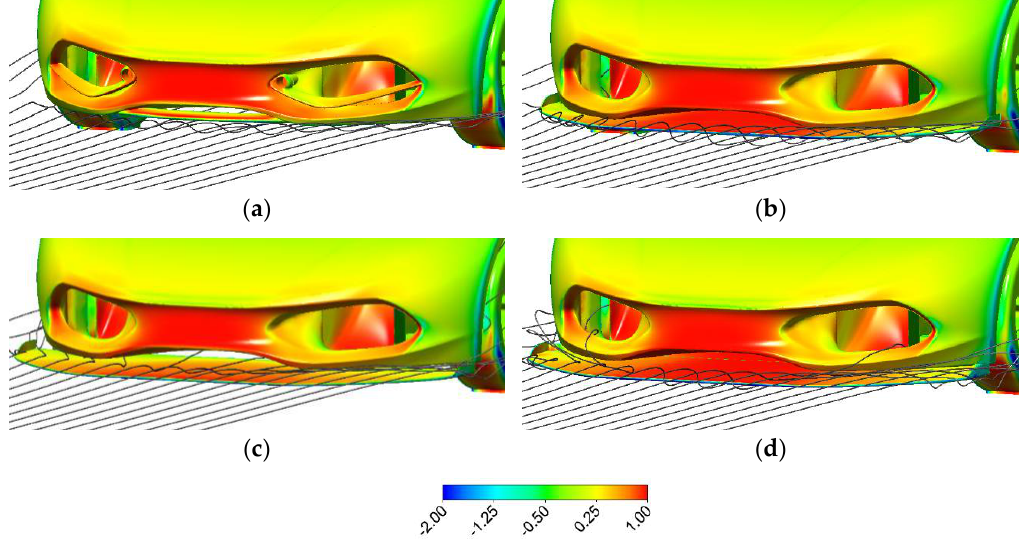
Figure 7. Contours of pressure coefficient on the car’s body with superimposed pathlines: ( a ) Base geometry; ( b ) retracted spoiler; ( c ) deployed spoiler; and ( d ) deployed spoiler with a vertical plate.